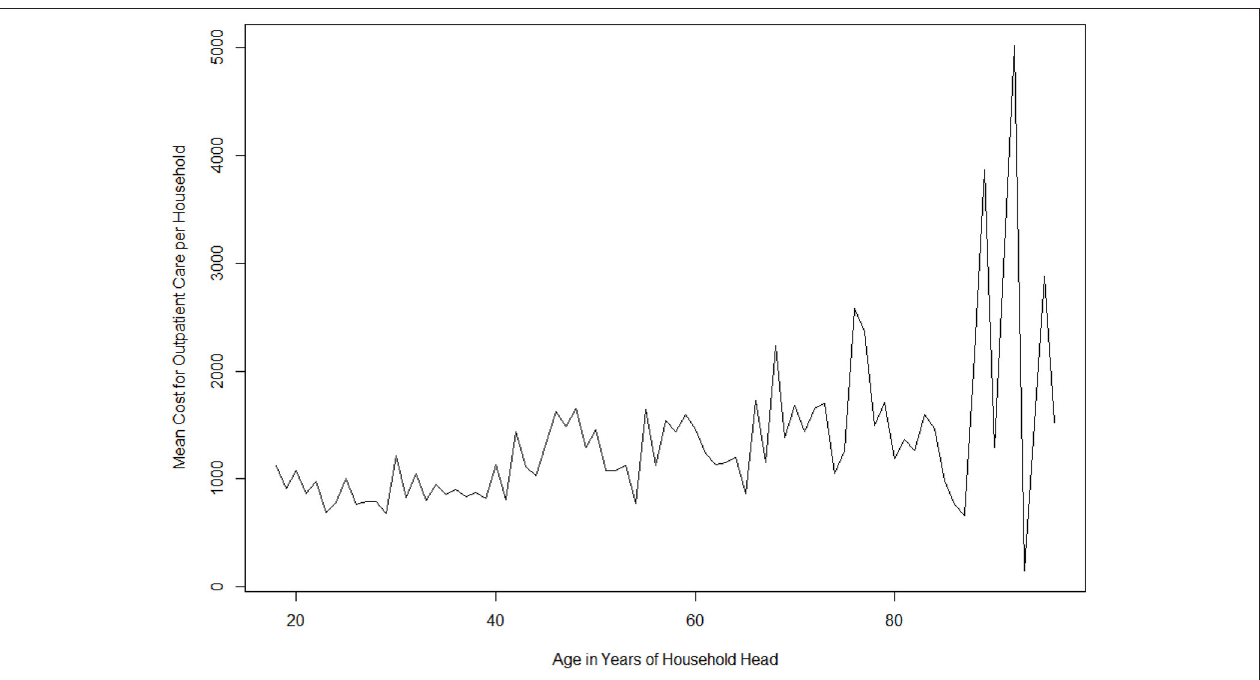
FIGURE 2 | Variations of mean cost for outpatients by household head age.